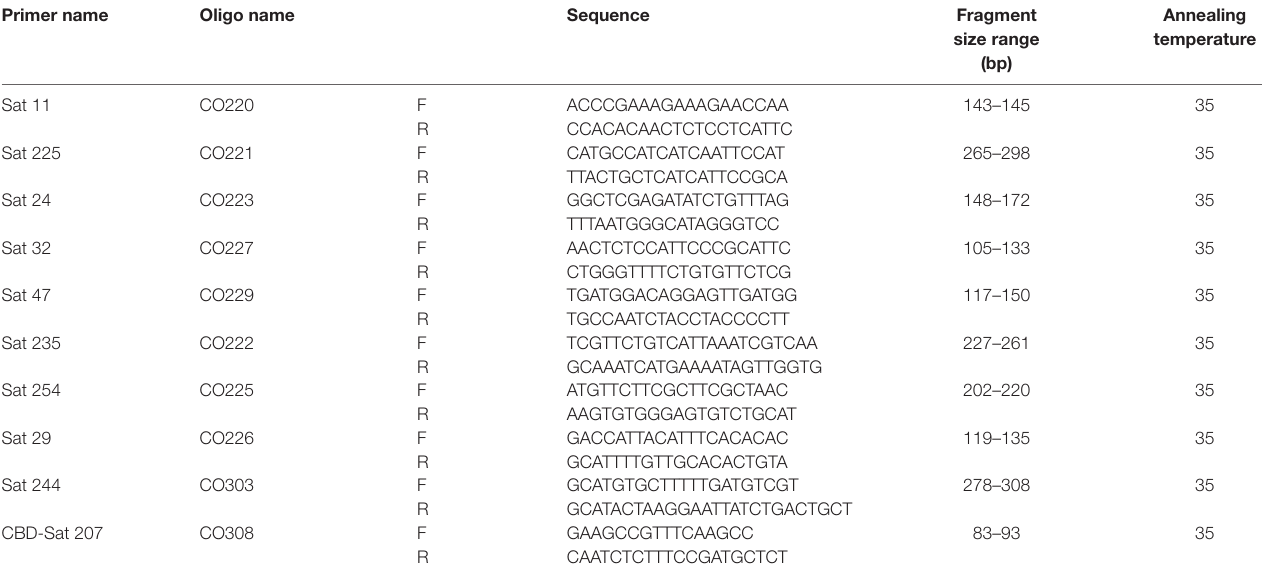
TABLE 2 | List of primers used in simple sequence repeat analysis. The primer sequences, the range size (in base pairs) of amplified fragment, and annealing temperatures used in polymerase chain reaction reactions are indicated for each primer